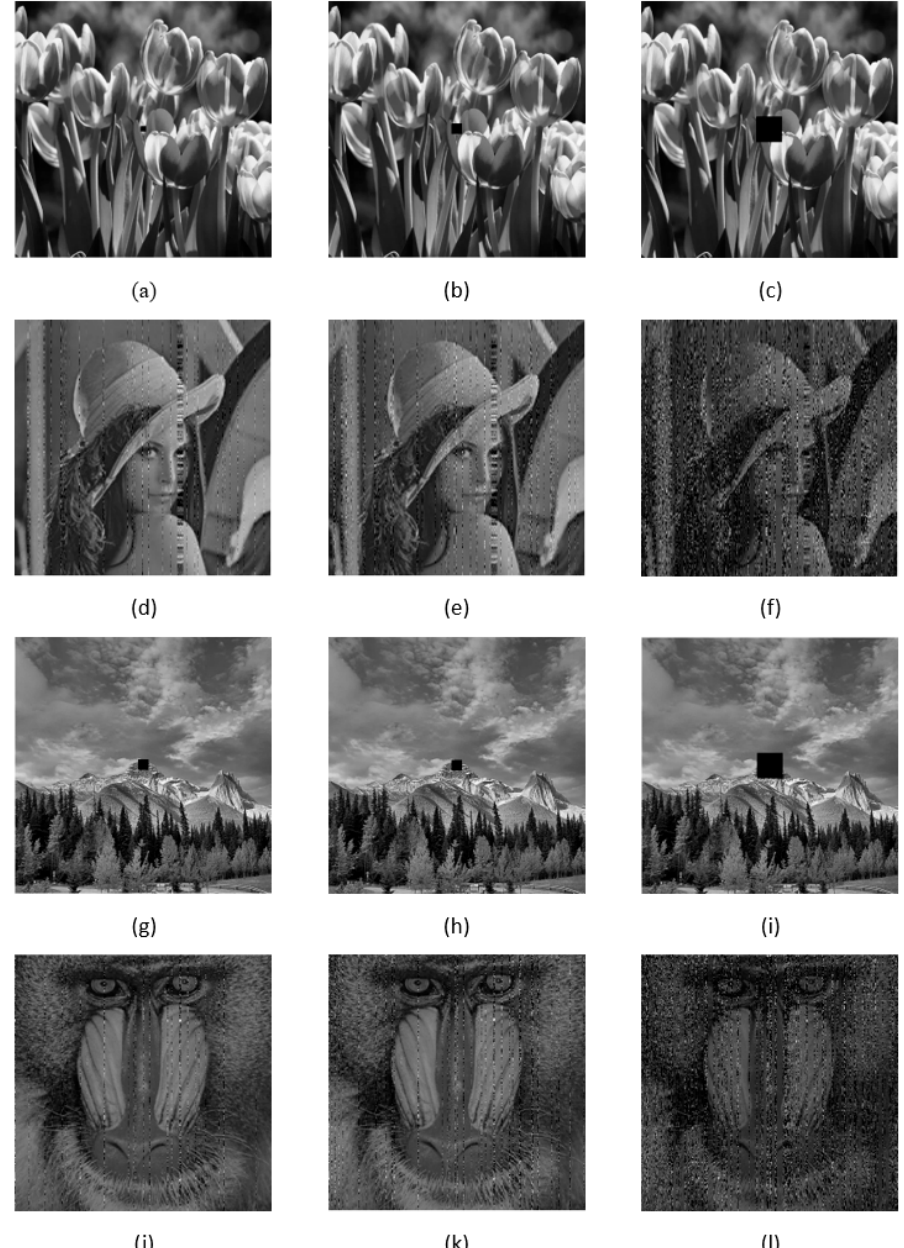
Figure 13. Analysis of images with a portion being cut. ( a – c ) The embedded images of flower, cut by 100, 400 and 2500 pixels, respectively. ( d – f ) The reconstructed decrypted images of Lena. ( g – i ) The embedded images of mountain, cut by 100, 400 and 2500 pixels. respectively. ( j – l ) The reconstructed decrypted images of baboon.